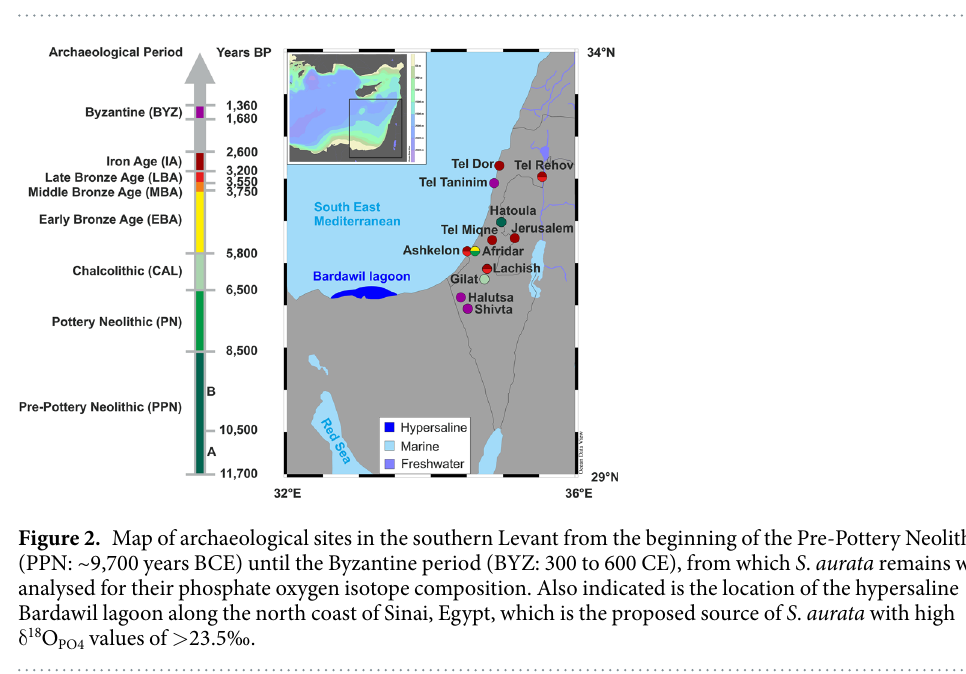
Figure 1. A map of the Bardawil Lagoon of the northern Sinai coast – the main nursery of Sparus aurata in the southeast Mediterranean basin.